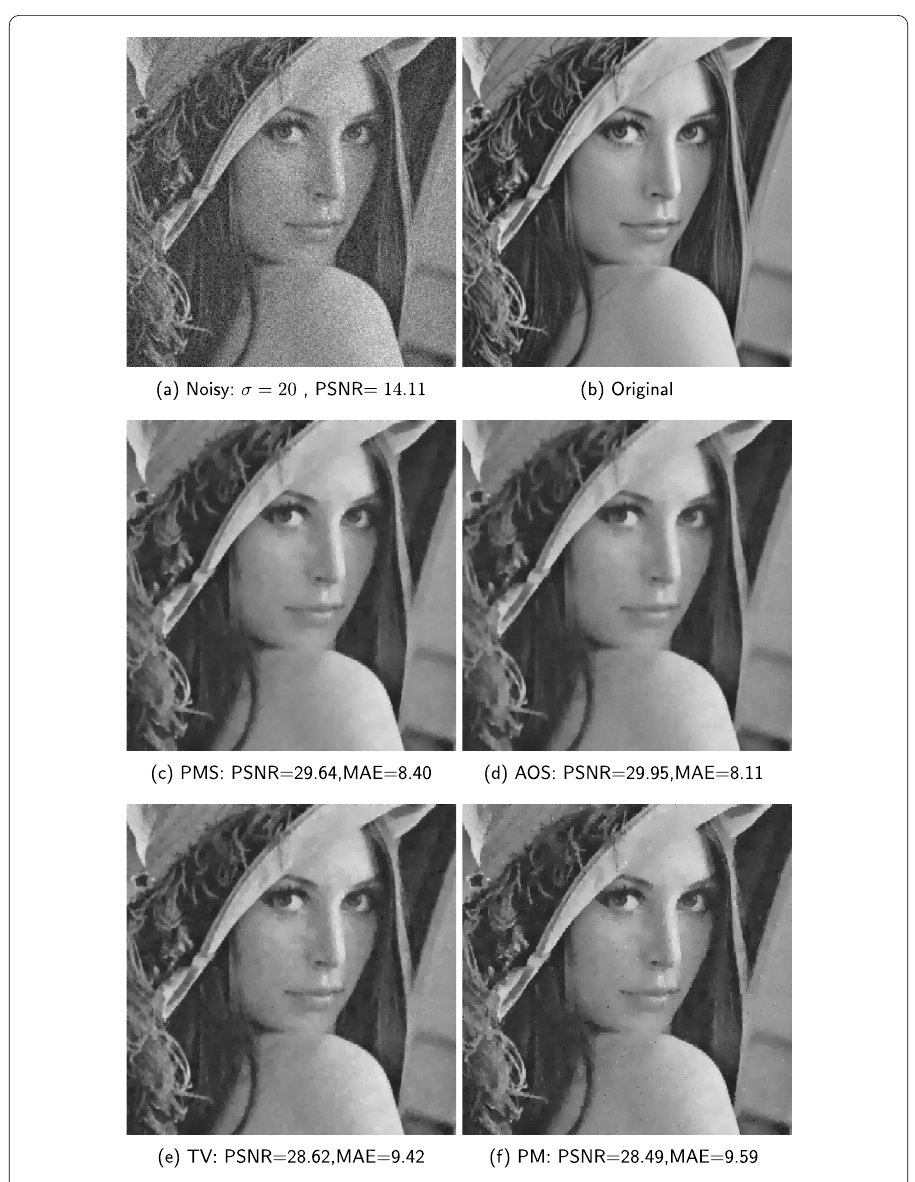
Figure 4 Lena image (300 × 300): ( a ) noisy image corrupted by Gaussian noise for σ = 20; ( b ) original image; ( c ) our algorithm by PMS, μ 1 = 0.3, μ 2 = 0.7, and τ = 0.2; ( d ) our algorithm by AOS, μ 1 = 0.9, μ 2 = 0.1, and τ = 2; ( e ) TV algorithm, τ = 0.2; and ( f ) PM algorithm, τ = 0.2 and K =